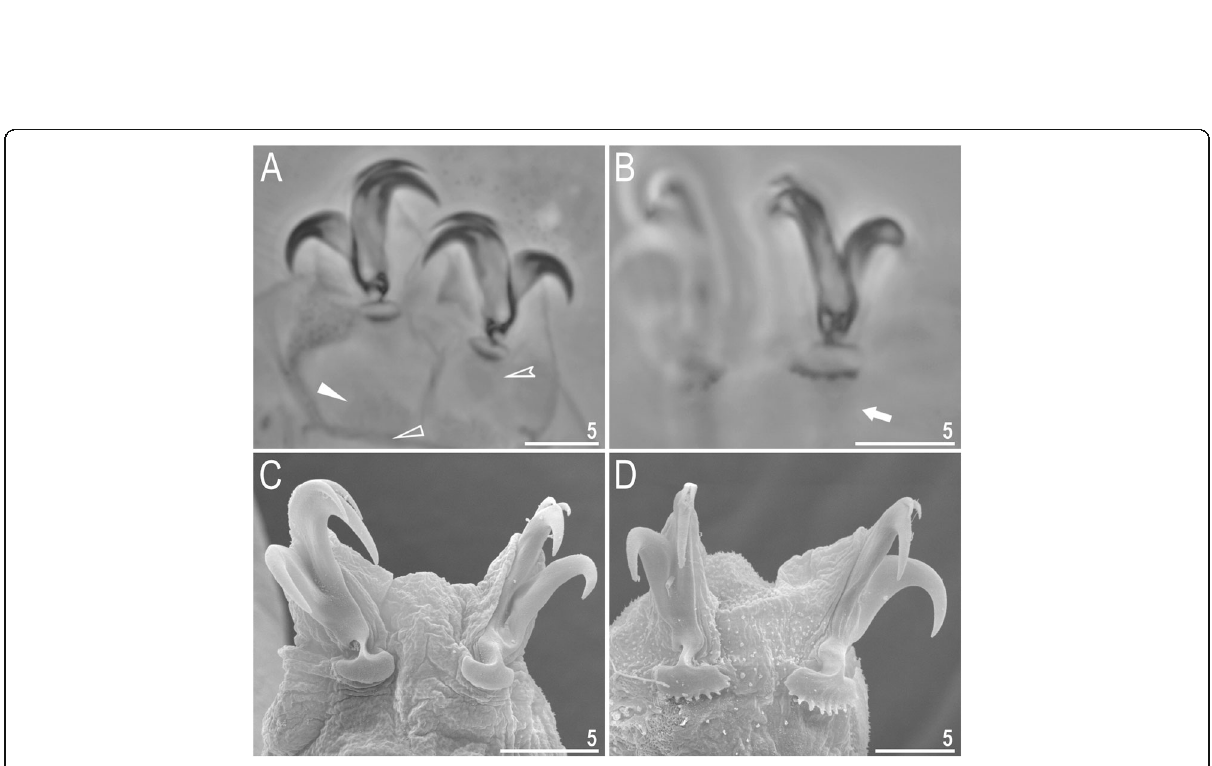
Fig. 33 Macrobiotus margoae sp. nov. from USA (US.057) – claw morphology: a – b – claws II and IV seen with LCM; c – d – claws III and IV seen with SEM. Empty indented arrowhead indicates dark circular areas under lunulae on the first three pairs of legs, filled flat arrowhead indicates cuticular bar above muscle attachments, empty flat arrowhead indicates double muscle attachments under claws, arrow indicates horseshoe structure connecting the anterior and the posterior claws. Scale bars in μ